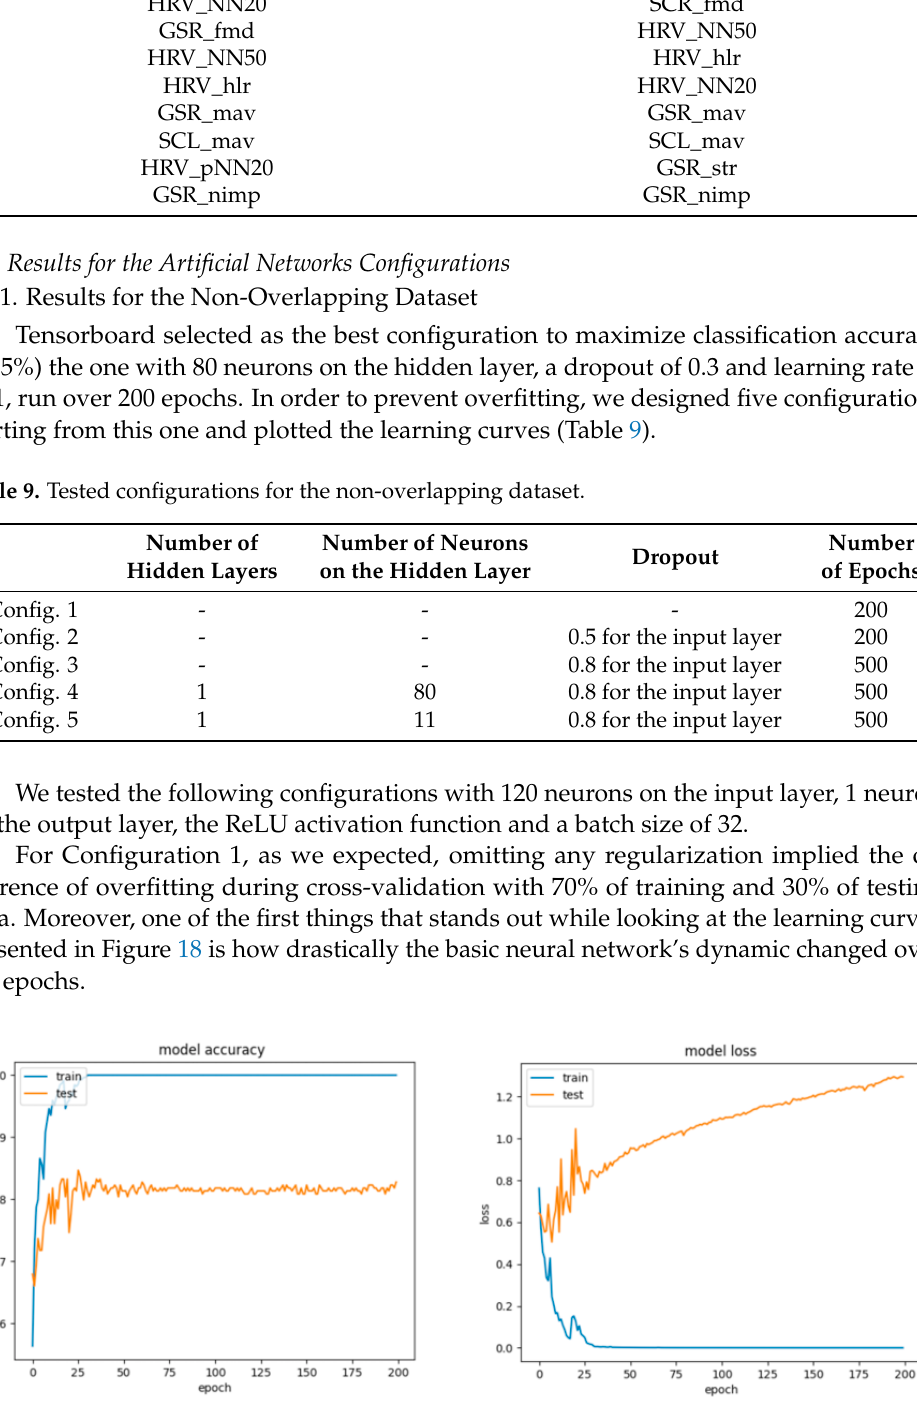
Figure 18. Accuracy and loss for Configuration 1, non-overlapping dataset.